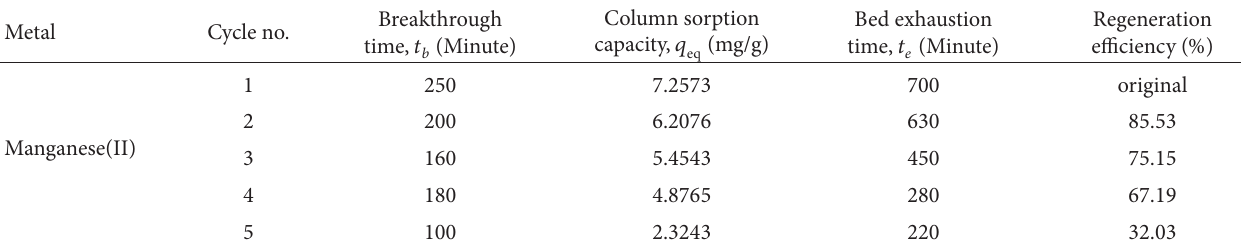
T 6: Regeneration of